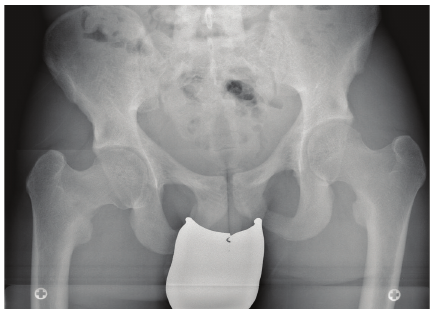
Figure 1: Standard pelvic radiograph taken 4 years ago showing no radiographic evidence of a fracture.